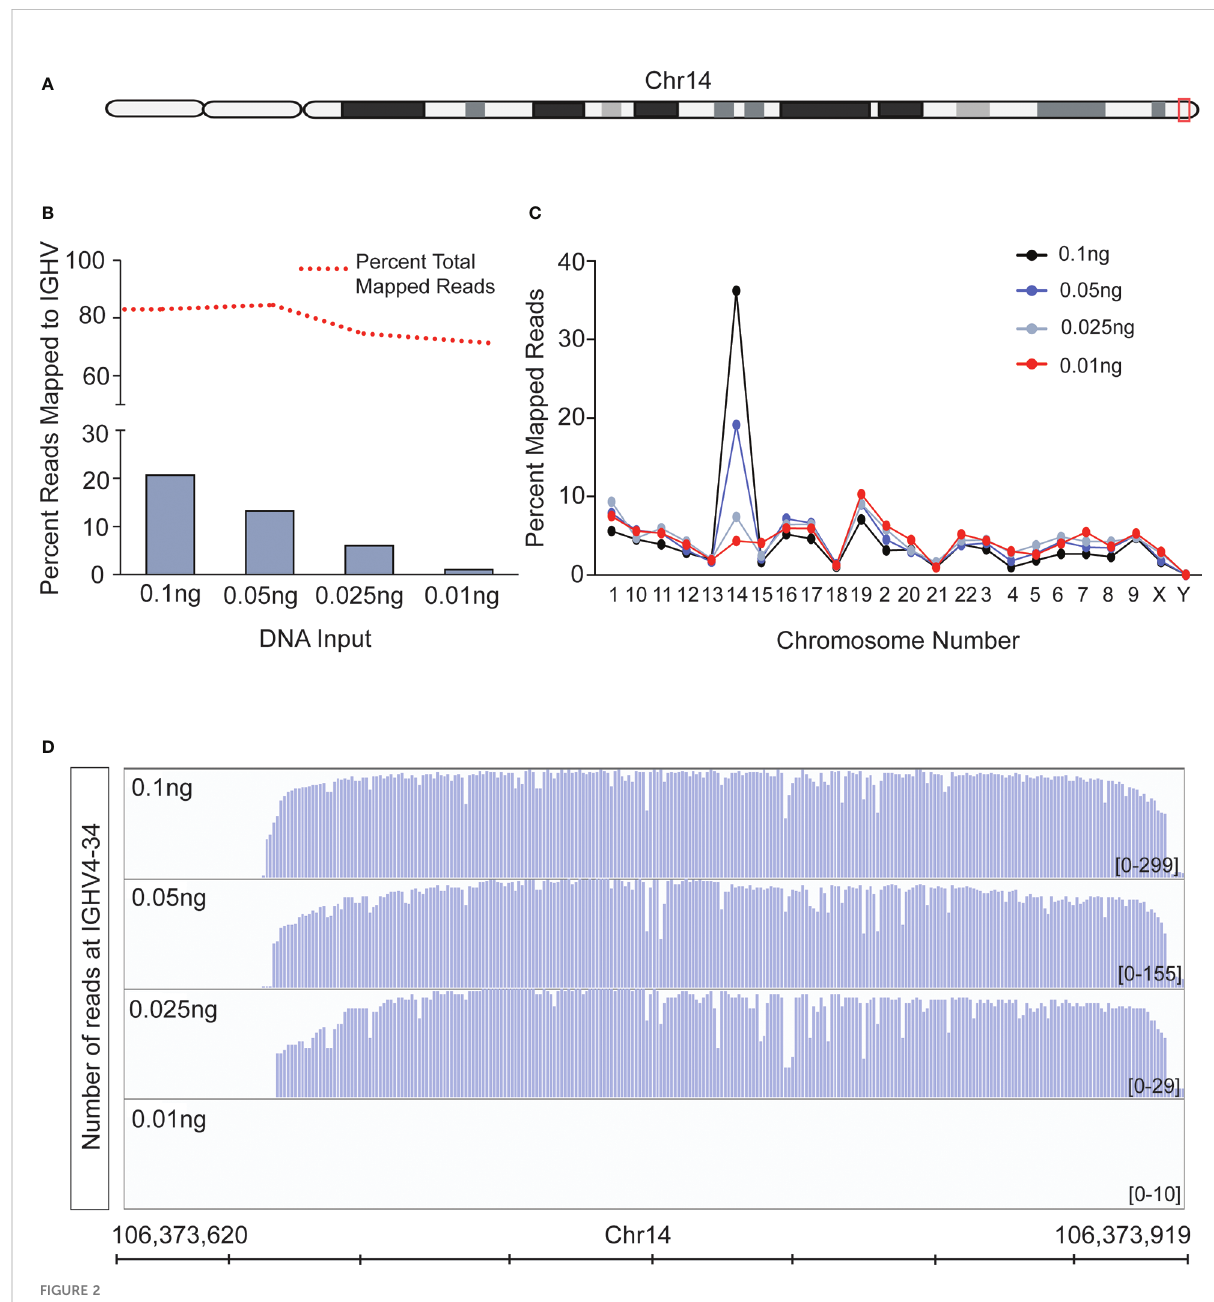
FIGURE 2 The MinION sequencing work fl ow can reliably detect IGHV reads in as little as 25 picograms of DNA. (A) Schematic of chromosome 14. The red box denotes the region containing the IGHV sequence to which all MinION reads were aligned. (B) The IGHV region was PCR ampli fi ed from the indicated input amount of normal tonsil DNA. Approximately 4,000 reads were obtained from the resulting libraries using nanopore MinION sequencing. The red dashed line shows the percent of all reads mapped to the human genome, and the bars denote the percentage of those mapped to the IGHV sequence. (C) The percent of all reads mapped from the samples in (B) are plotted across all chromosomes. (D) Alignment plots to a selected IGHV, V4-34, show accurate reads alignment when the input DNA is as little as 0.025ng, or a threshold of 20 reads mapped to IGHV over other